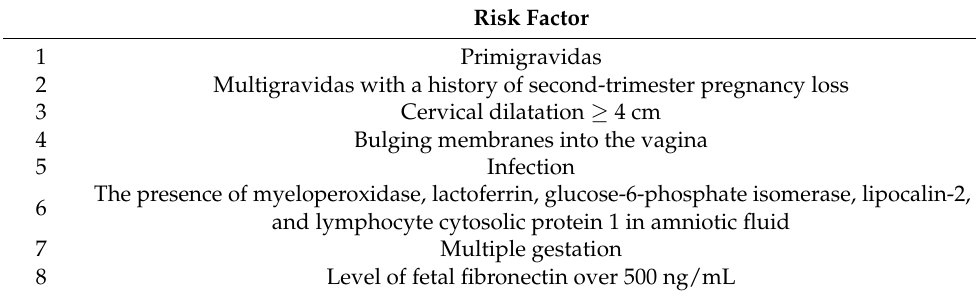
Table 2. Risk factors of the emergency suture